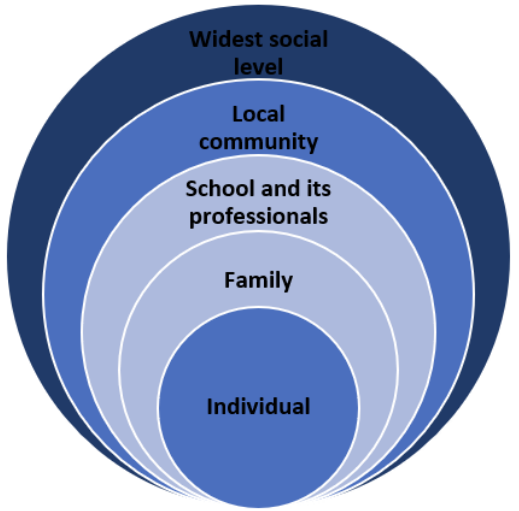
Figure 1. Interpretative model by Gamella (2011). Source: EduCig Project,